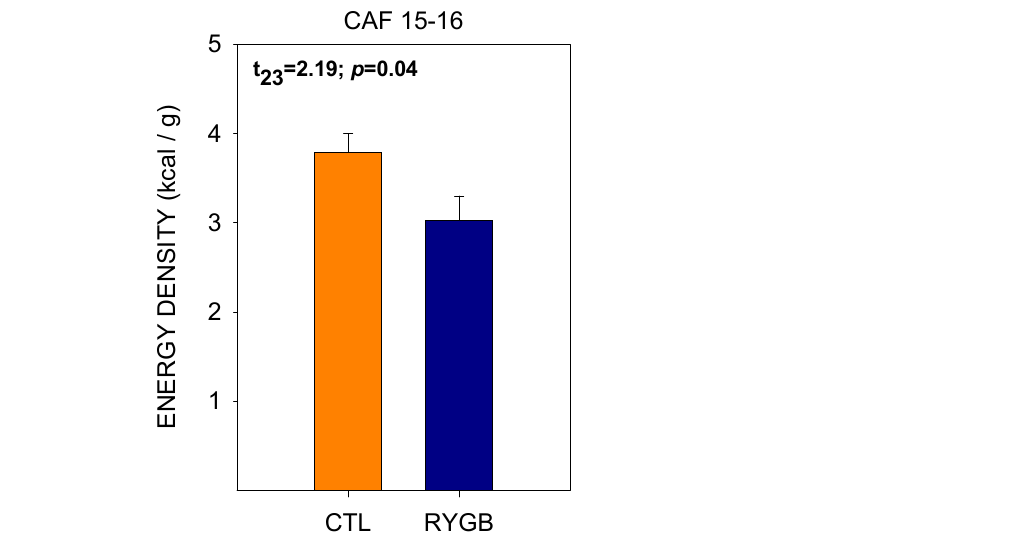
Figure 12. Energy Density of Meals. Mean ( ± SE) energy density for all meals consumed during the last cafeteria diet days by CTL ( n = 14; orange bars) and RYGB ( n = 11; blue bars). Inset: results of t -tests comparing groups.